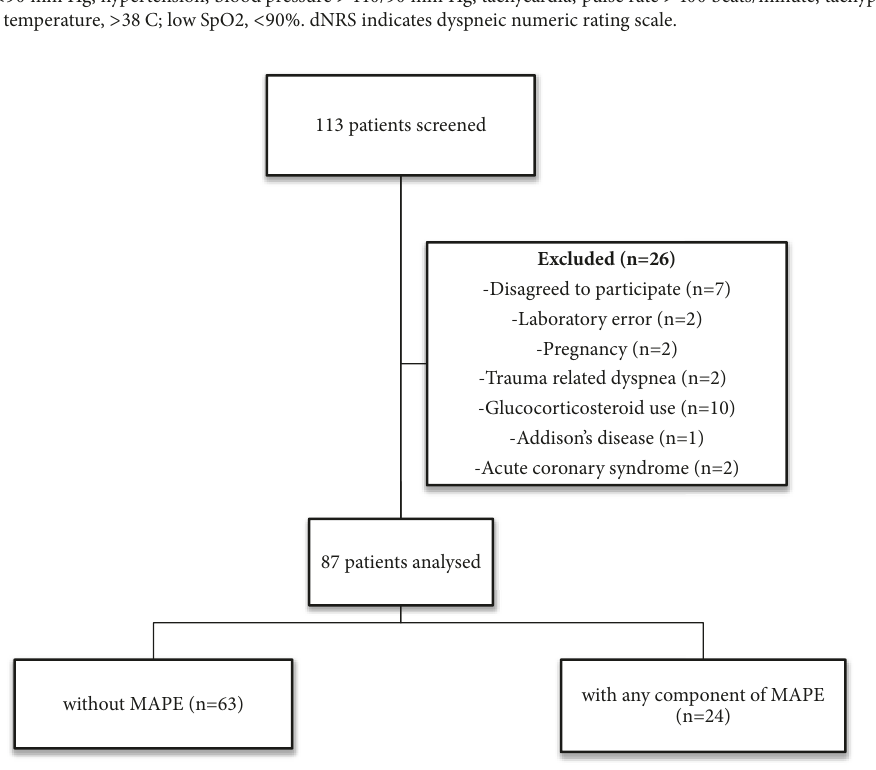
Figure 1: The patient flow